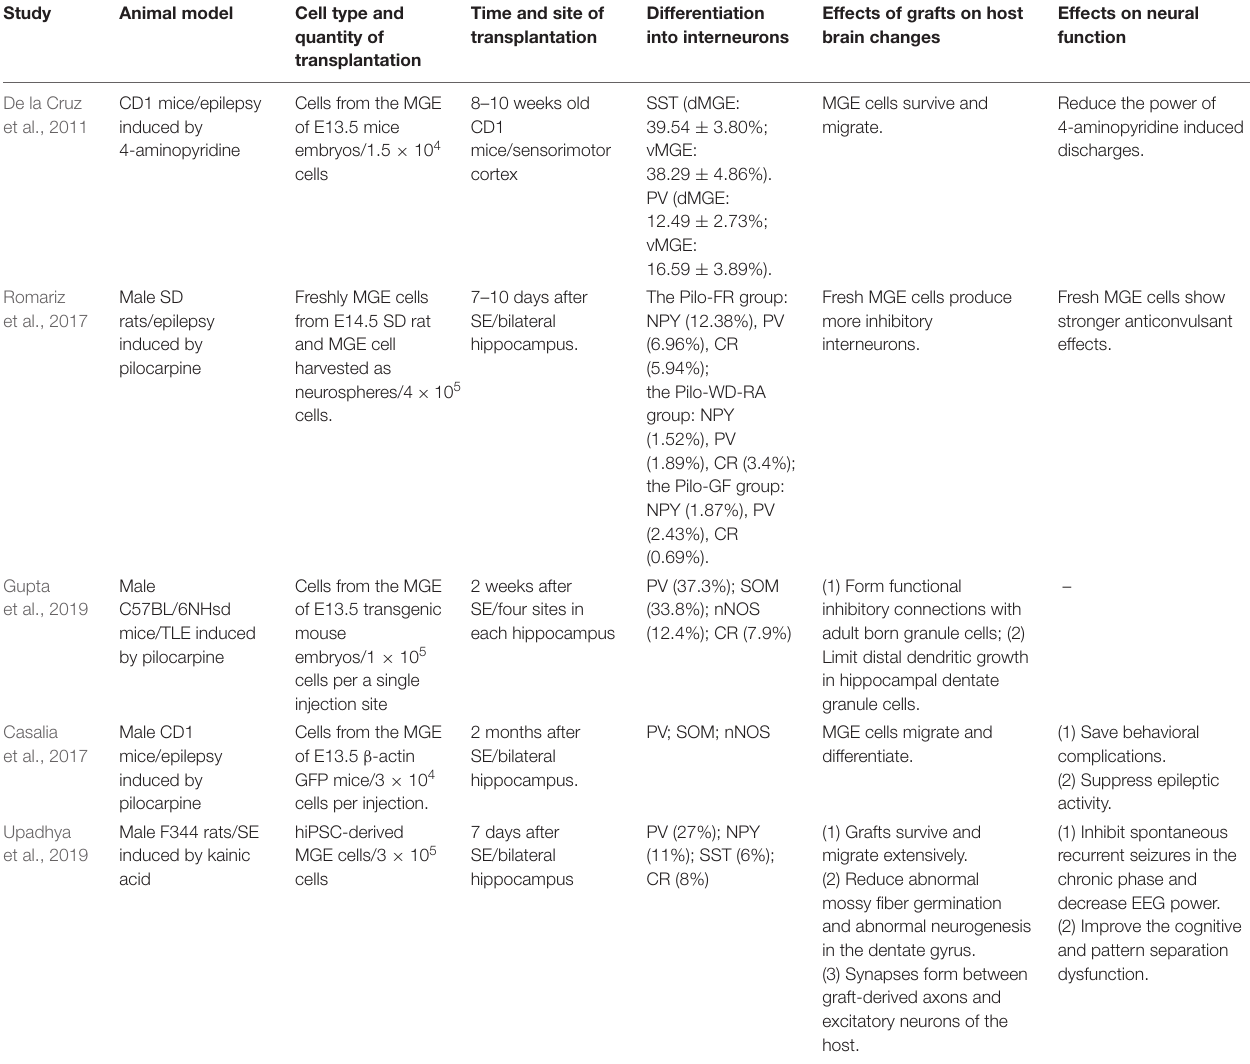
TABLE 1 | Medial ganglionic eminence (MGE) cell transplantation for